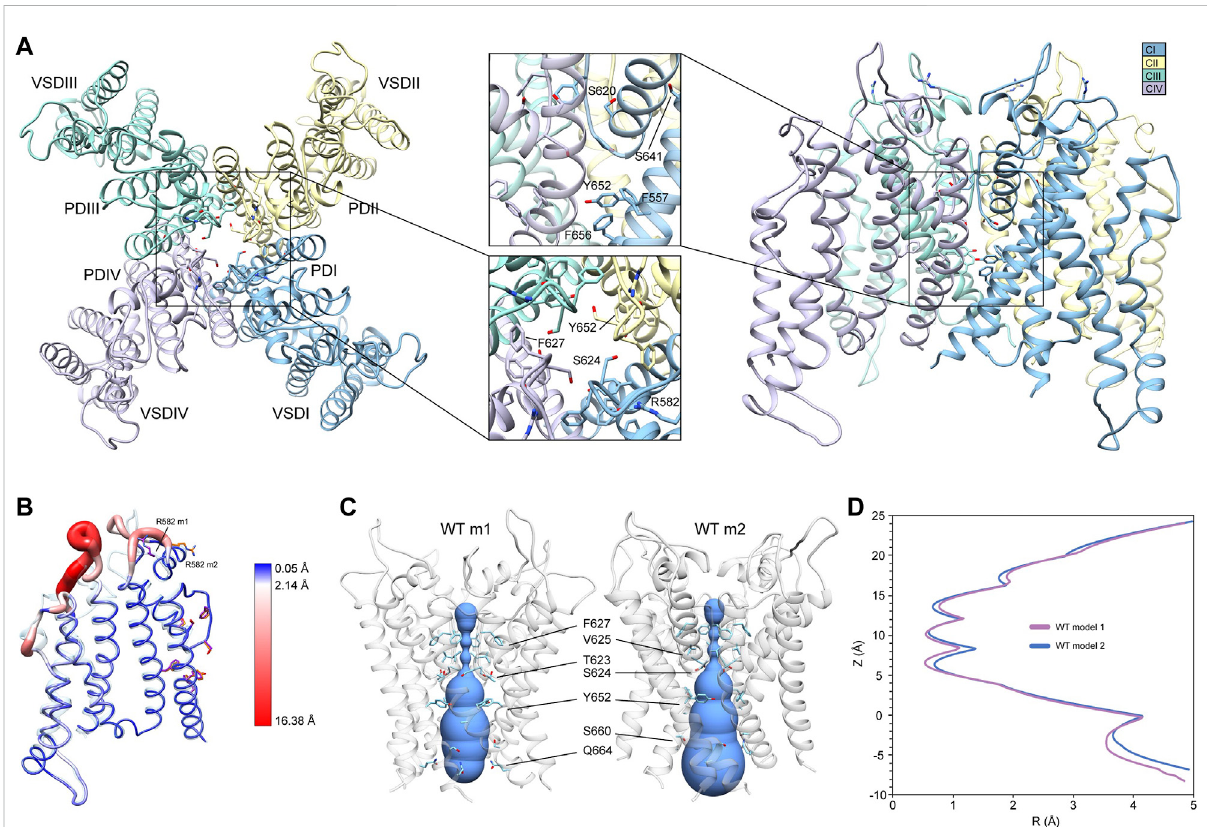
FIGURE 1 hERG WT channel model 1 (m1) and model 2 (m2) comparison. (A) Domain structure of hERG WT channel. Chains are coloredaccording to the legend as CI-CIV. PD, pore domain; VSD, voltage sensing domain. Chain I is colored in blue, chain II is colored in yellow, chain III is colored in green, and chain IV is colored in violet. (B) Overlay of hERG WT m1 and m2 models. M1 model is in translucent light-blue cartoon with purple residues, m2 model in noodle wireframe and color coded according to RMSD, with orange residues. (C) Van der Waals pore radius comparison for hERG WT m1 and m2 models. Volume spheres are in blue, with surrounding residues in light blue. (D) hERG WT m1 (purple) and m2 (blue) pore radius, R , pro fi les as a function of z generated by the HOLE program (Smart et al.,